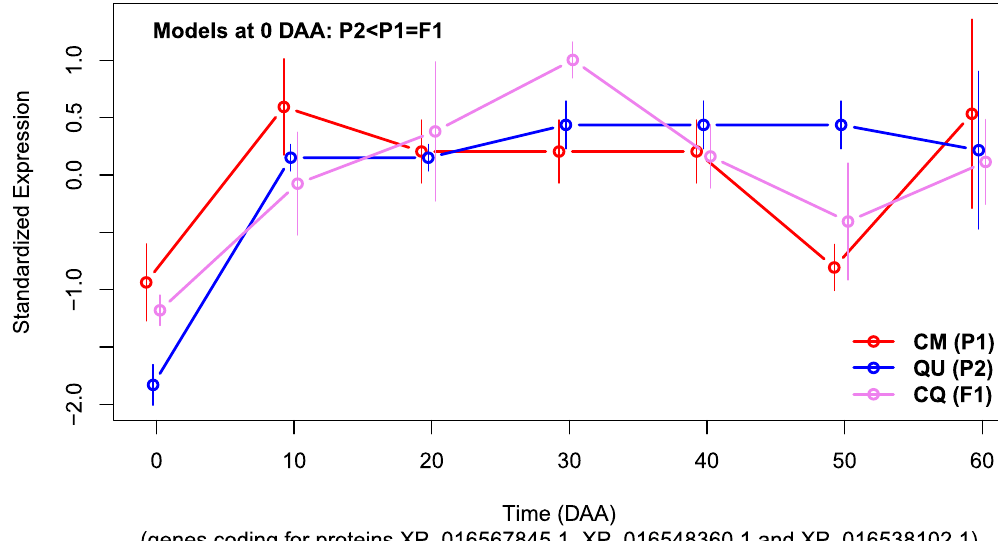
Figure 6. Standardized Expression Profiles (SEPs) for the sets of the three genes annotated in BP “negative regulation of growth” in accessions CM, QU and CQ. Confidence Intervals (CIs) for each SEP at each time are presented as thin vertical lines.